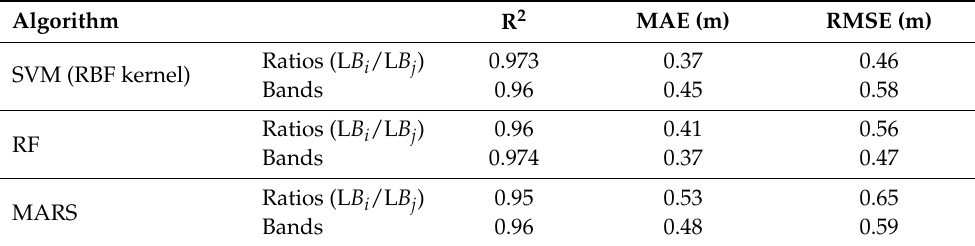
Table 3. Error statistics in meters for the SVM, RF and MARS algorithms and the Luarca Port testing dataset.